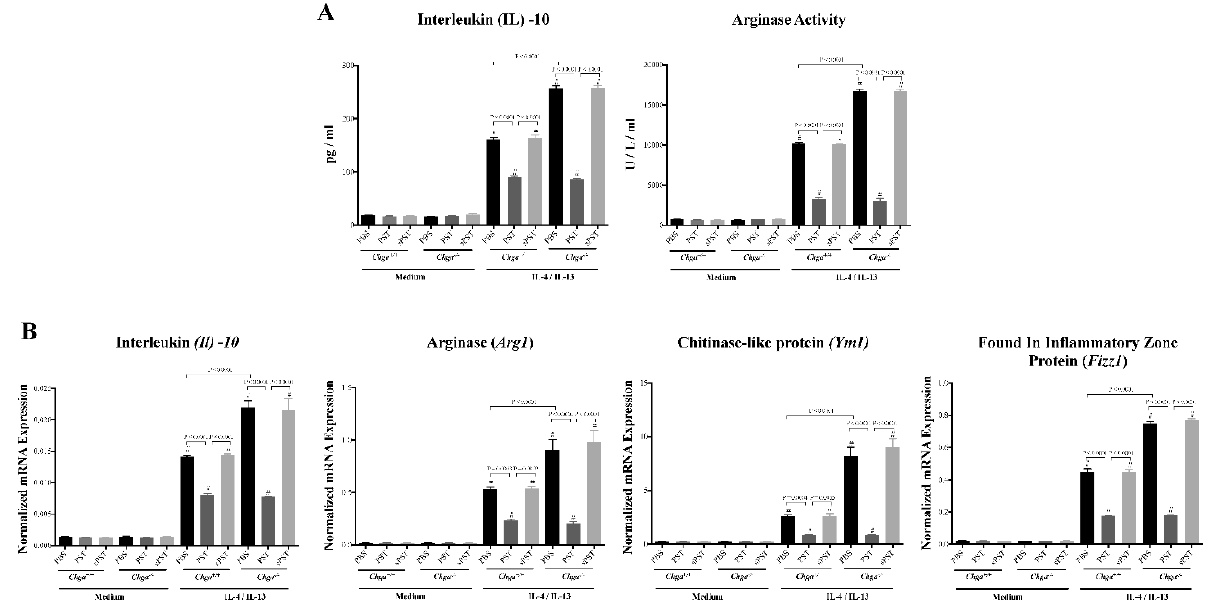
Figure 6. In vitro, pancreastatin (PST) pretreatment decreases the functional capacity of naïve macrophages polarized toward an alternative-activated macrophages profile (AAM). Peritoneal macrophages were isolated from naïve Chga +/+ and Chga −/− mice. Macrophages were pretreated with PST or sPST (200 ng/mL) or 1% PBS for four hours, then stimulated by interleukin (IL)-4/IL-13 (20 ng/mL) for six h and conditioned medium was harvested. ( A ) Medium protein levels of IL-10 and arginase activity. ( B ) Cell mRNA expression of AAM markers ( Il10 , arginase [ Arg1 ], chitinase-like protein [ Ym1 ], and Found in inflammatory zone protein [ Fizz1 ]). ELISA quantified protein level and activity. Quantitative real-time RT–PCR quantified mRNA expression. The relative mRNA expression was determined by calculating the difference in the threshold cycle (ΔCt) method. One-way ANOVA followed by multiple comparison tests. Each value represents the mean ± SEM, n = 9 mice/group. # refers to significance compared with medium control groups. Each experiment was repeated at least three times.